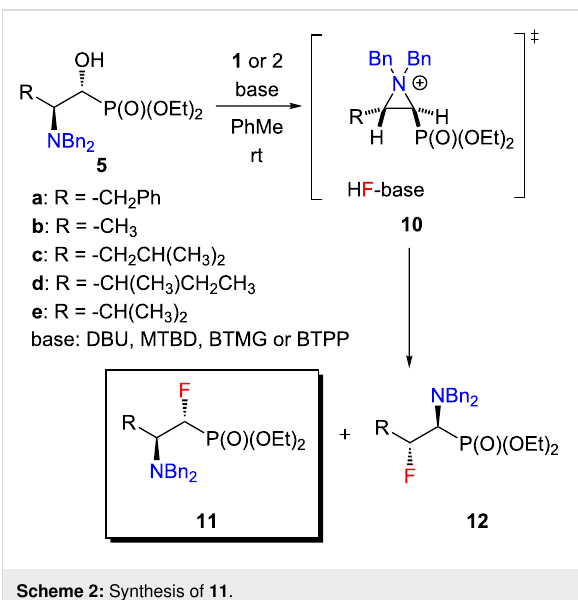
Scheme 2: Synthesis of 11 .